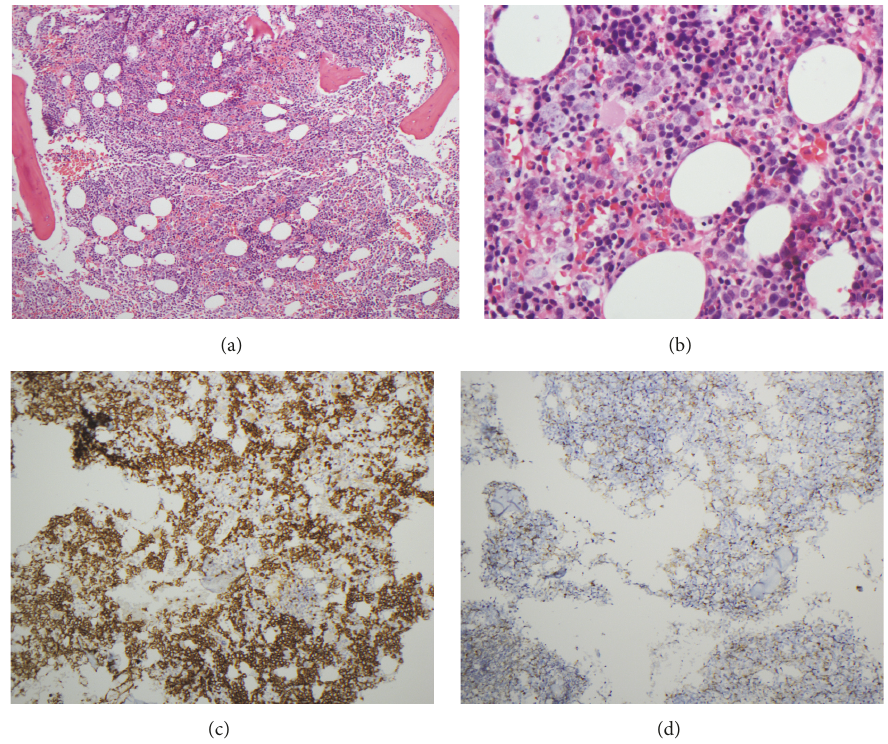
Figure 1: Bone marrow biopsy. (a, b) Representative areas of hematoxylin and eosin-stained sections of the bone marrow biopsy ((a) 10x, (b) 40x). (c) Immunohistochemical (IHC) staining for the erythroid marker CD71 (10x). (d) IHC stain for the myeloid marker MPO